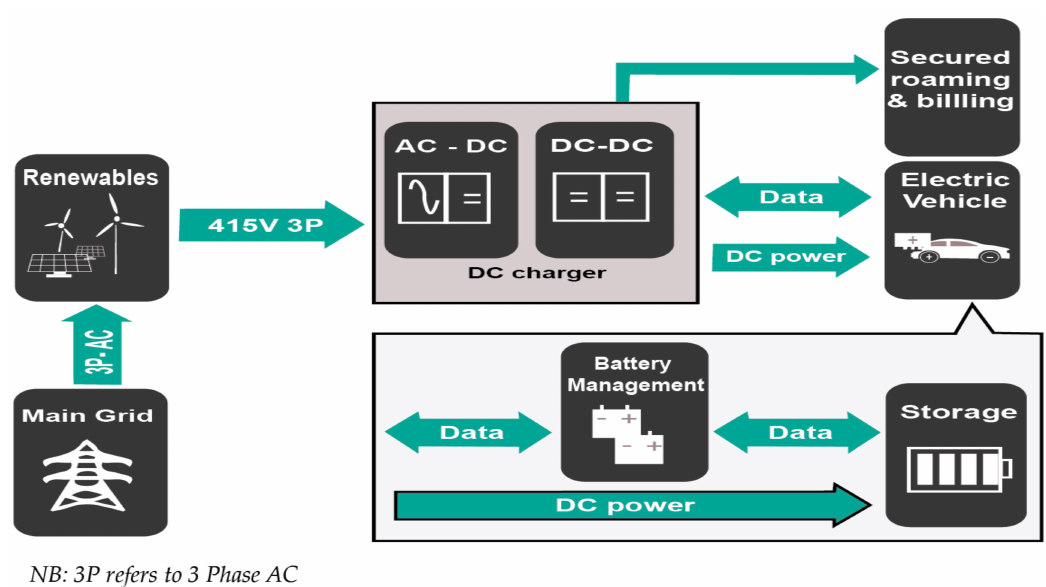
Figure 2. EV DC rapid charger elements illustrating communication—charger fed by renewable micro-grid. Adapted from Infineon